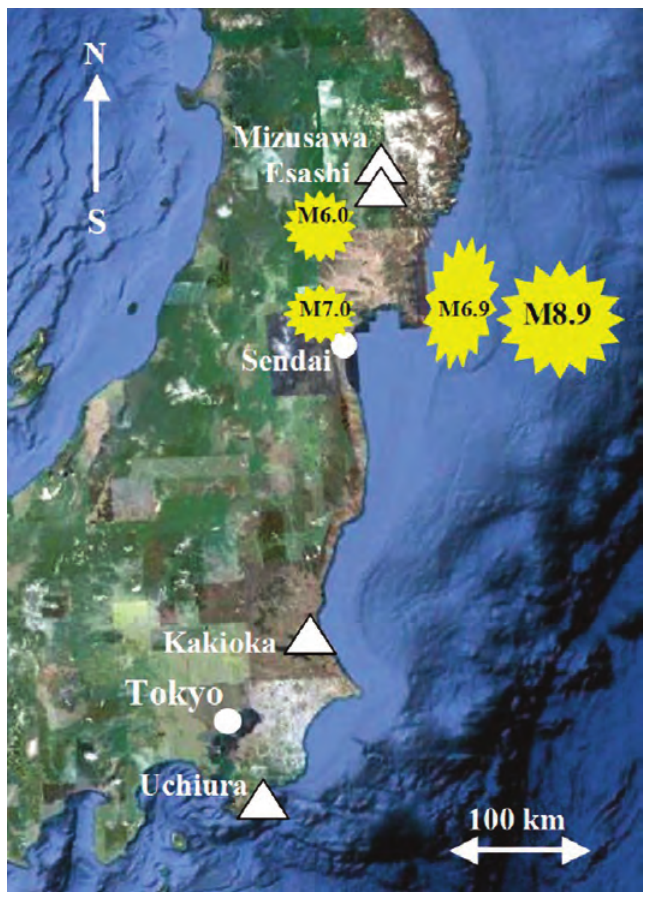
Figure 1. Location of the magnetic stations (white triangles) and the areas of strong seismic activity (yellow stars) during the period of January 1, 2000, to January, 2011.